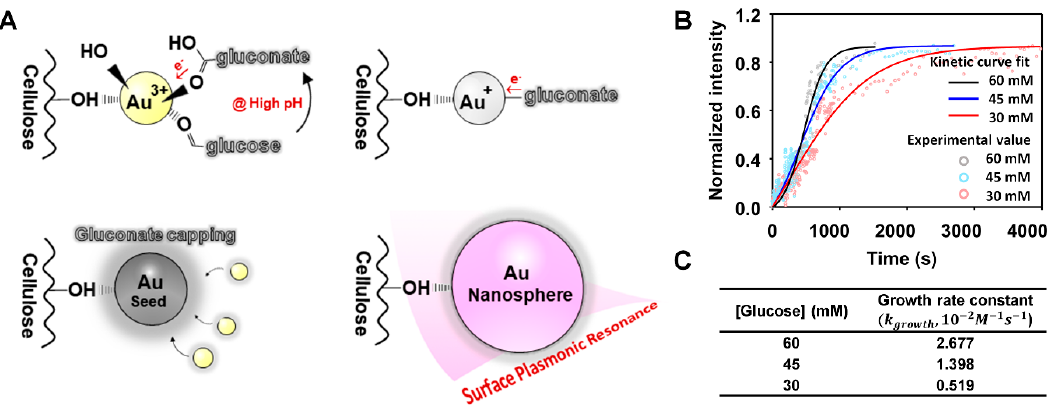
Figure 3. Project mechanism of in situ gold nanospheres synthesis. ( A ) Schematics depicting stepwise reactions throughout the glucose transformation triggered by hydroxide, the subsequent reducing reaction, gold seed formation and its growth and gluconate-based capping effect; ( B ) kinetic curve fit data with 30, 45 and 60-mM glucose samples; ( C ) calculated total growth rate constants.